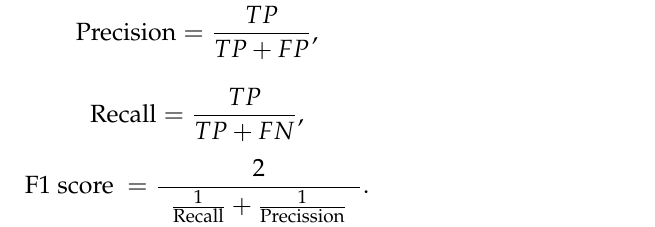
the classification median, while horizontal lines denote 25th and 75th percentile. The graph shows an